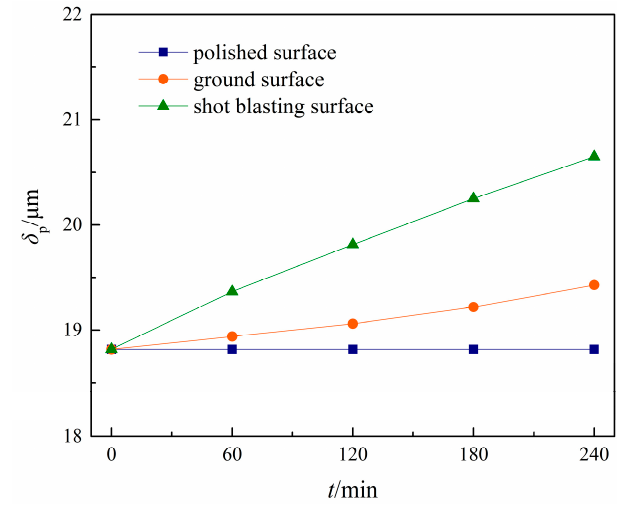
Figure 15. Variation of the of the δ p .